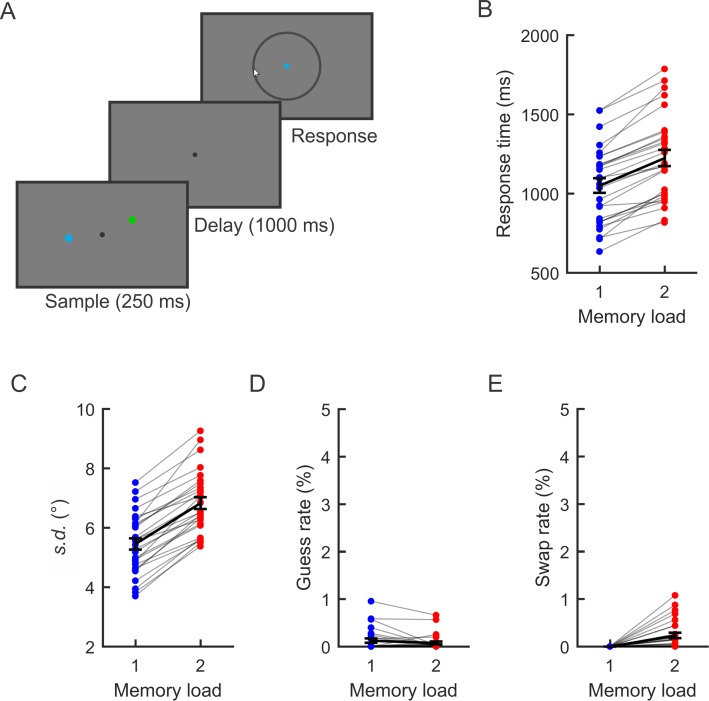
Experimental task and behavior.(A) Observers saw a brief sample display (250 ms) that contained 1 or 2 colored dots. After a delay period (1,000 ms), the fixation point changed color (blue or green) to indicate which item should be reported. Observers reported the angular position of the cued item as precisely as possible by mouse click on the perimeter of a rim. (B) Median response time (ms) as a function of memory set size (1 versus 2 items). Light grey lines represent individual observers. Black lines represent the mean. Error bars represent ±1 SEM. (C–E) Parameter estimates obtained by fitting a three-component mixture model [50] to response errors as a function of memory set size. s.d. (panel C) reflects precision of responses (with higher values indicating worse precision), pGuess (panel D) estimates the probability that the observer produced a random response (i.e., a guess), and pSwap (panel E) estimates the probability that the uncued item was misreported instead of the cued item. Note that pSwap is necessarily 0 for the single-item condition. Data are available at https://osf.io/47cmn/. s.d., standard deviation of von Mises distribution.